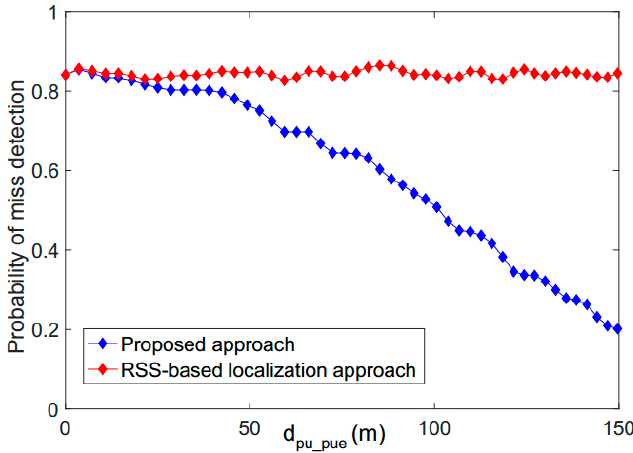
Figure 9. Comparison between the proposed technique and the RSS-based localization technique in terms of the probability of miss detection as a function of the distance.